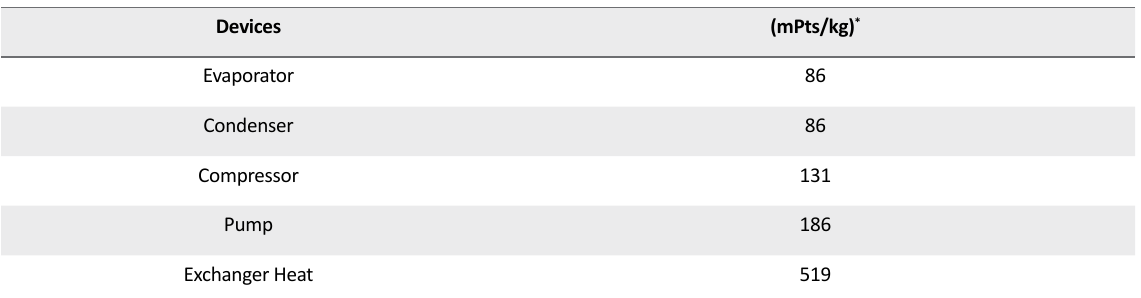
Table 4. Environmental index for equipment [59]